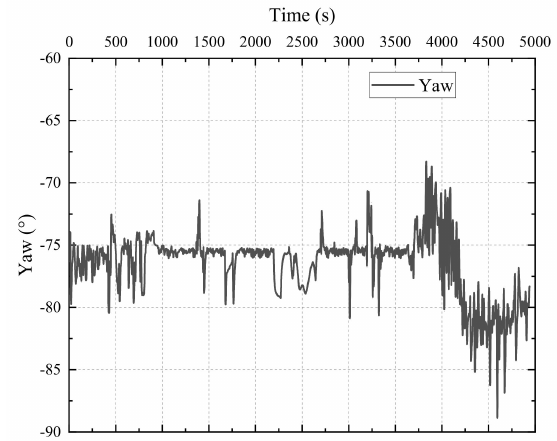
Figure 13. Yaw during